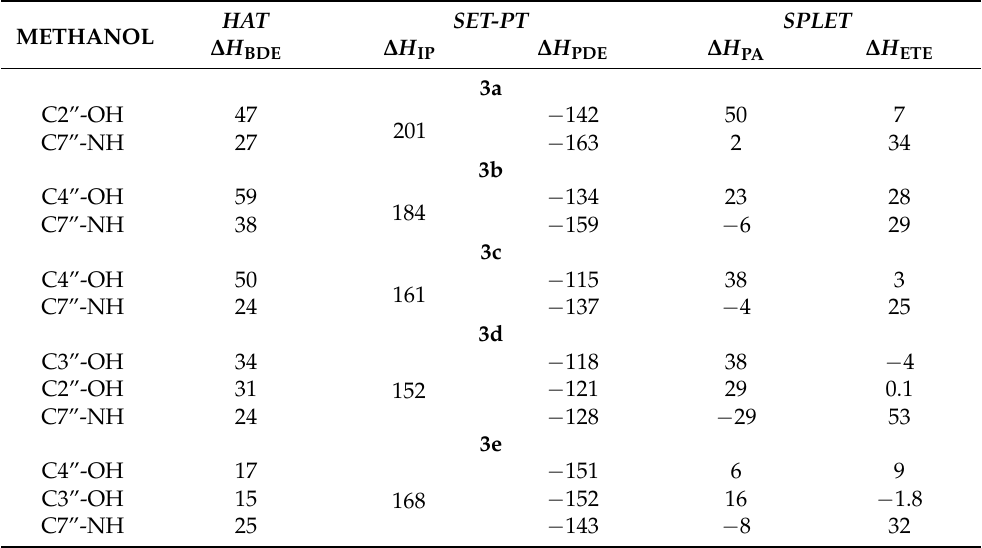
Table 5. Calculated parameters of radical scavenging activity for coumarin hybrids in kJ moL − 1 . METHANOL